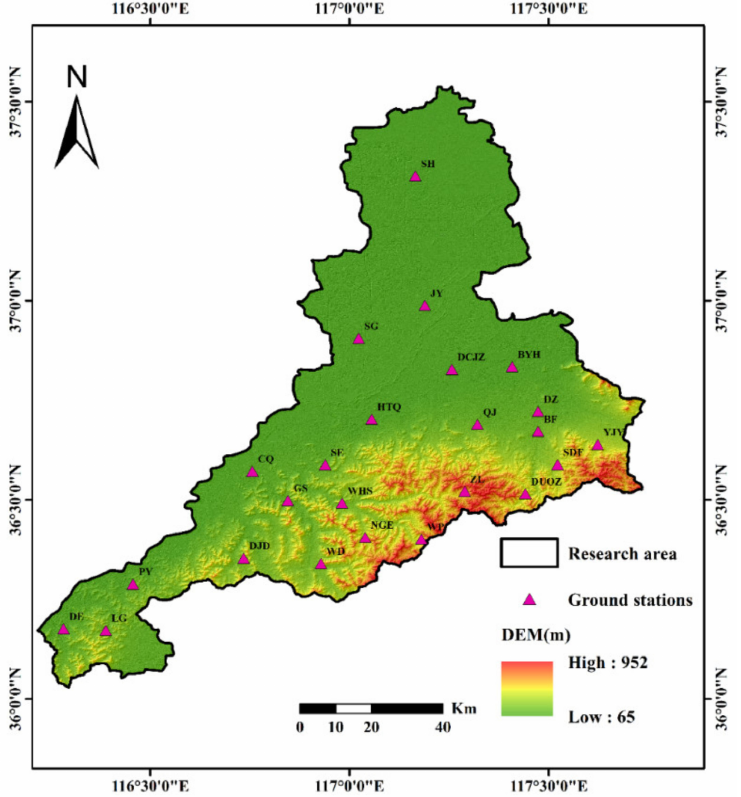
Figure 1. Digital elevation model (DEM) over the study area and land station